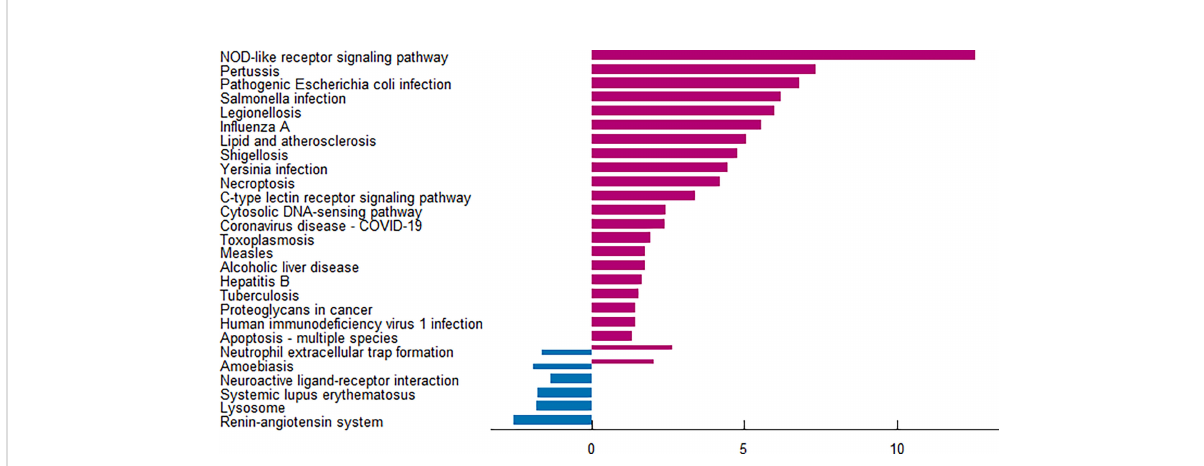
FIGURE 5 KEGG pathway analysis of 13 differentially expressed PRGs. According to the adjusted P -value, a total of 67 pathways were reported. KEGG, Kyoto Encyclopedia of Genes and Genomes; PRGs, pyroptosis-related genes.